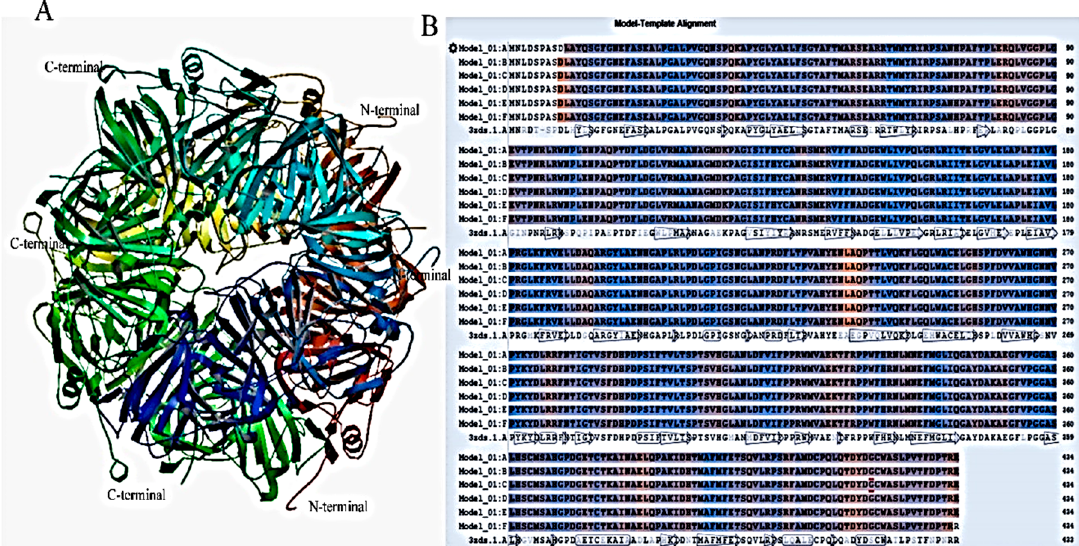
Figure 4. The model constructed by homology modeling at a SWISS-MODEL workspace using homogentisate 1,2-dioxygenase (H12D) from Pseudomonas chlororaphis as the template. ( A ) The predicted tertiary structure of H12D from Pc UFB2 deduced from 3zds.1.A; ( B ) Homology alignment of probable H12D from Pc UFB2 (Model_1) with H12D from Pseudomonas chlororaphis (3zds.1.A).